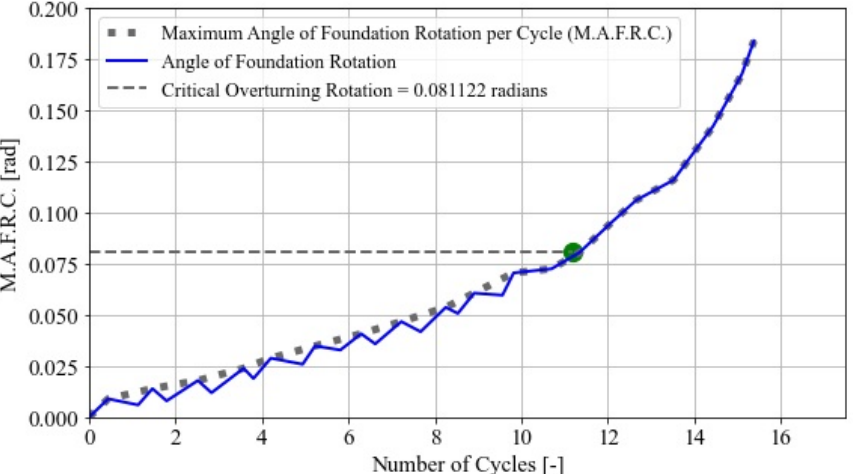
Figure 12. Maximum angle of the foundation rotation per cycle versus the number of cycles (MAFRC). The sample shows the number of cycles at overturning for Ottawa sand at 5.86 Hz and an amplitude of 0.2 mm for the oscillatory movement on the edge of the footing. The number of cycles at overturning was